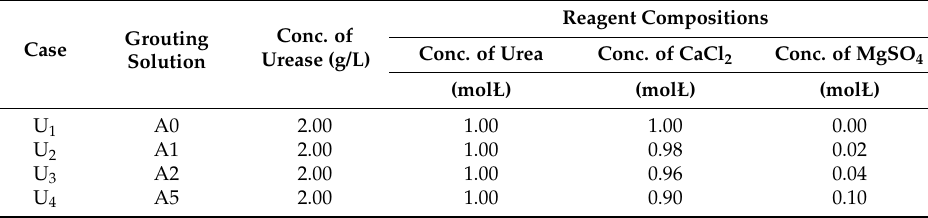
Table 4. Experimental conditions for PVC cylinder